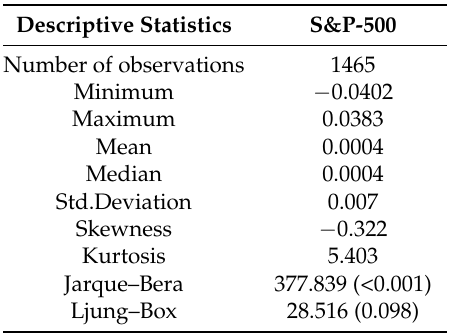
Table 5. Summary statistics for the S&P-500 index.